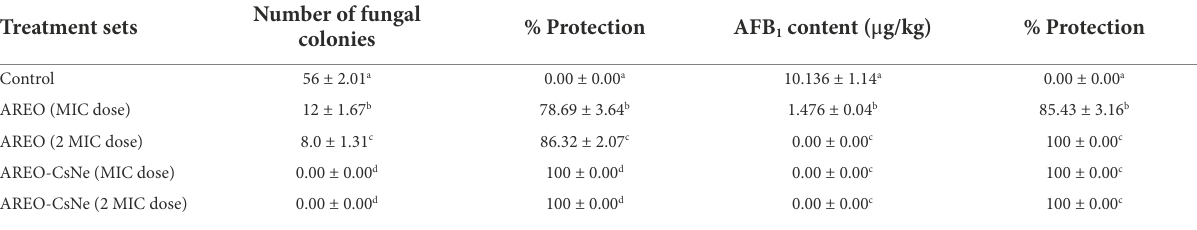
TABLE 6 Inhibition of fungal growth and AFB1 production in S. italica seeds by AREO and AREO-CsNe fumigation. Treatment